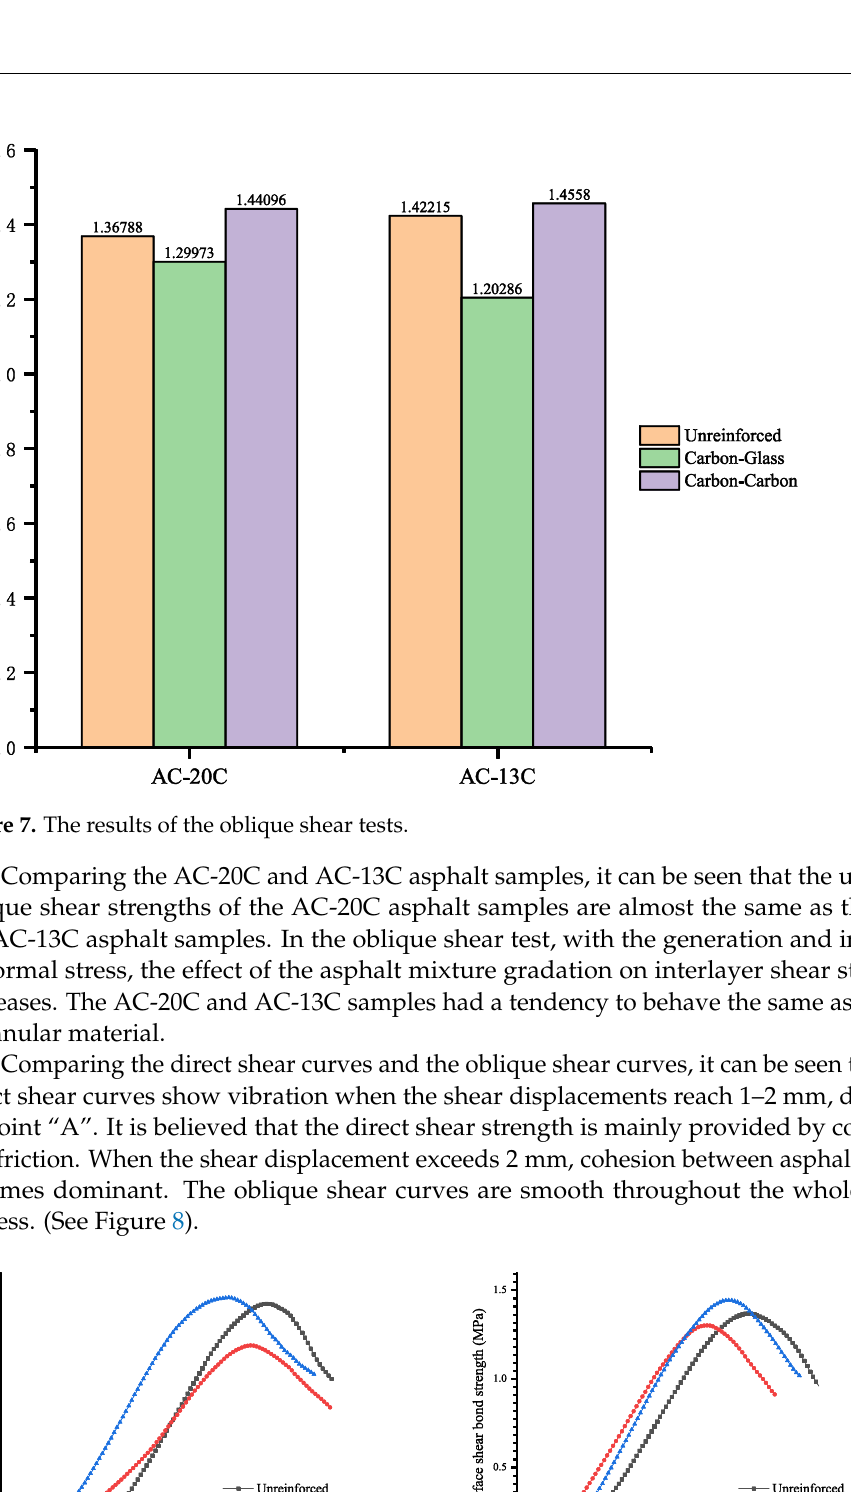
Figure 8. Interface shear strength vs. shear displacement curves in the oblique shear experiment. ( a ) AC-13C and ( b ) AC-20C.